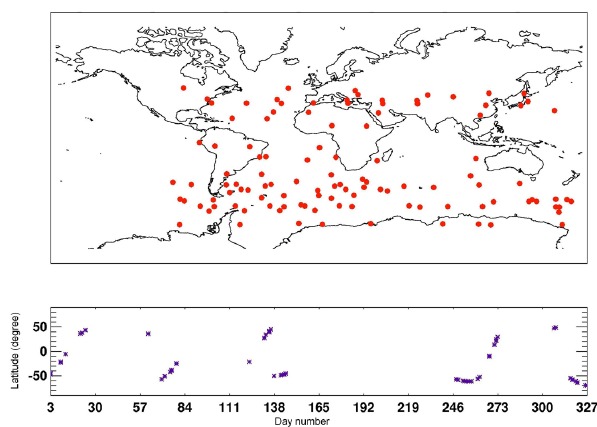
Fig. 7. Location of the SCIAMACHY measurement subset, (upper panel) and latitude (degree) vs. time (day number) (lower panel).